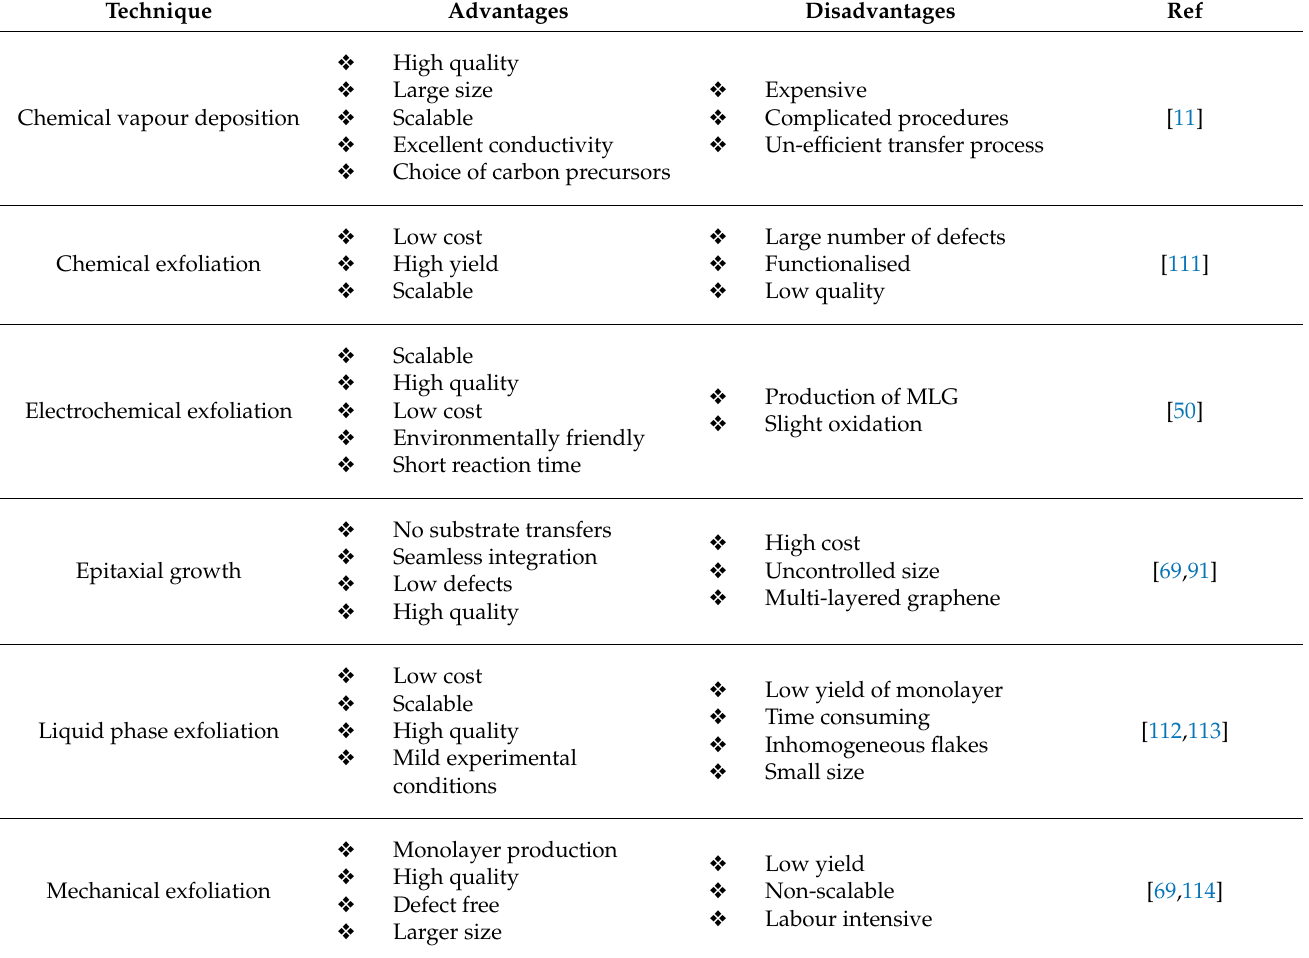
Table 1. Advantages and disadvantages of various synthesis techniques for graphene.